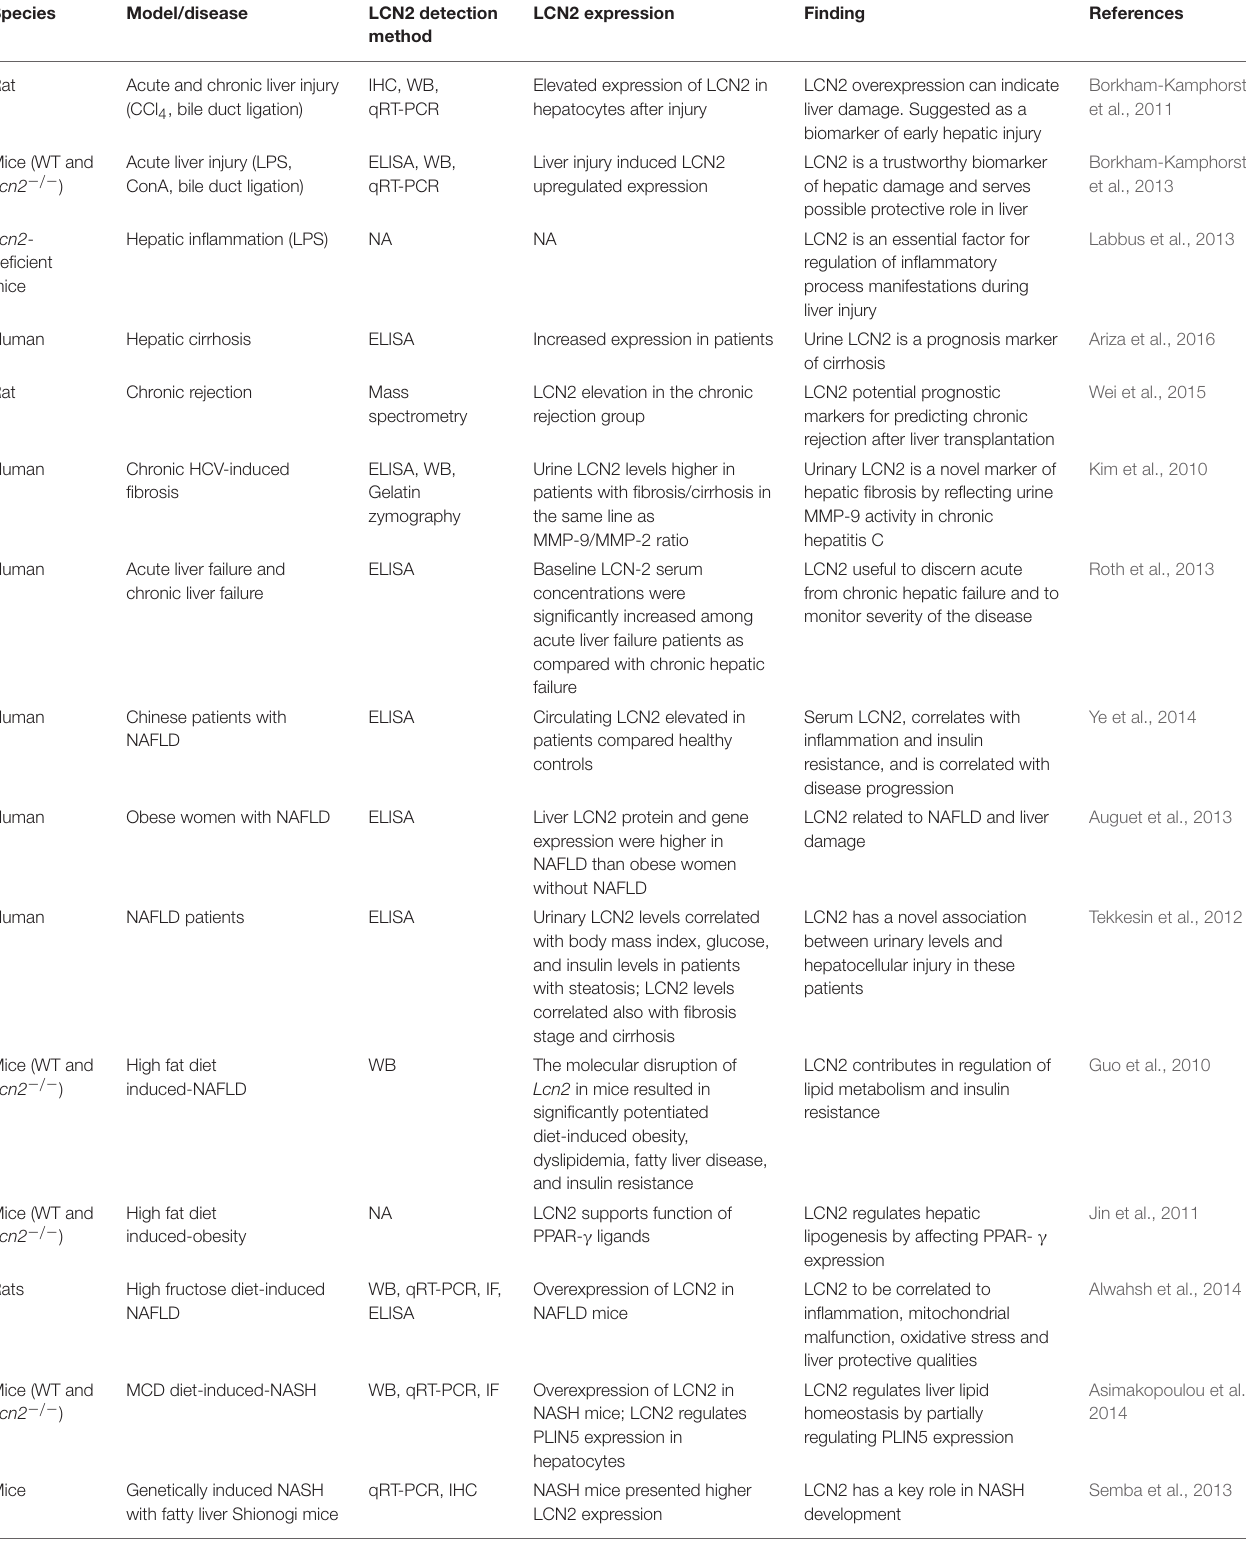
TABLE 3 | Selected experimental and clinical findings associated with altered LCN2 expression in liver.